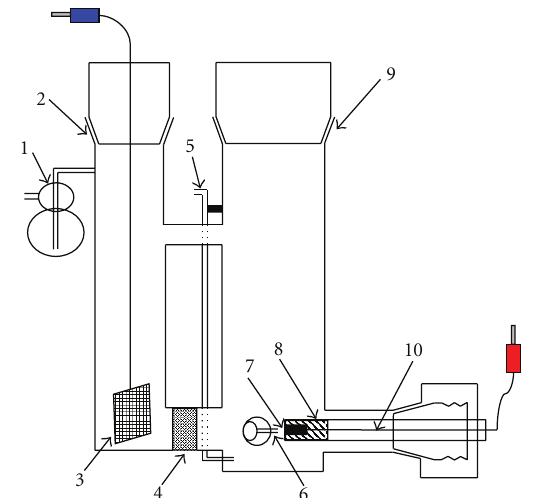
Figure 2: The electrochemical cell. (1) gas bubbler, (2) B 12 glass socket, (3) Platinum gauze (counter electrode), (4) glass frit, (5 ) inlet for nitrogen gas, (6 ) luggin capillary (reference electrode), (7 ) steel rod (working electrode), (8 ) epoxy resin, (9 ) B 24 glass socket, (10 ) copper